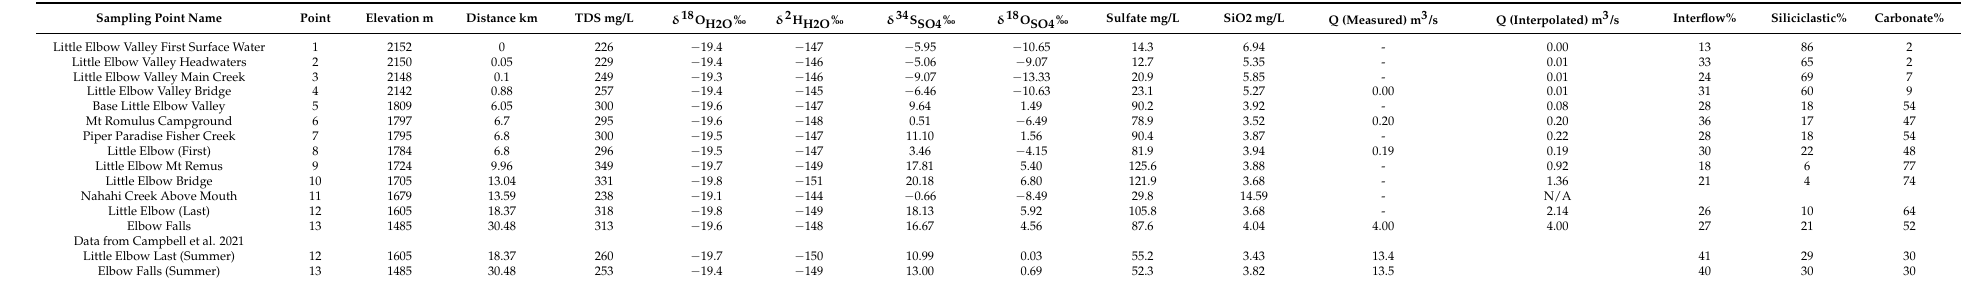
Table 1. Ion and Isotope Data for 26 October Longitudinal Streamflow and Representative Summer